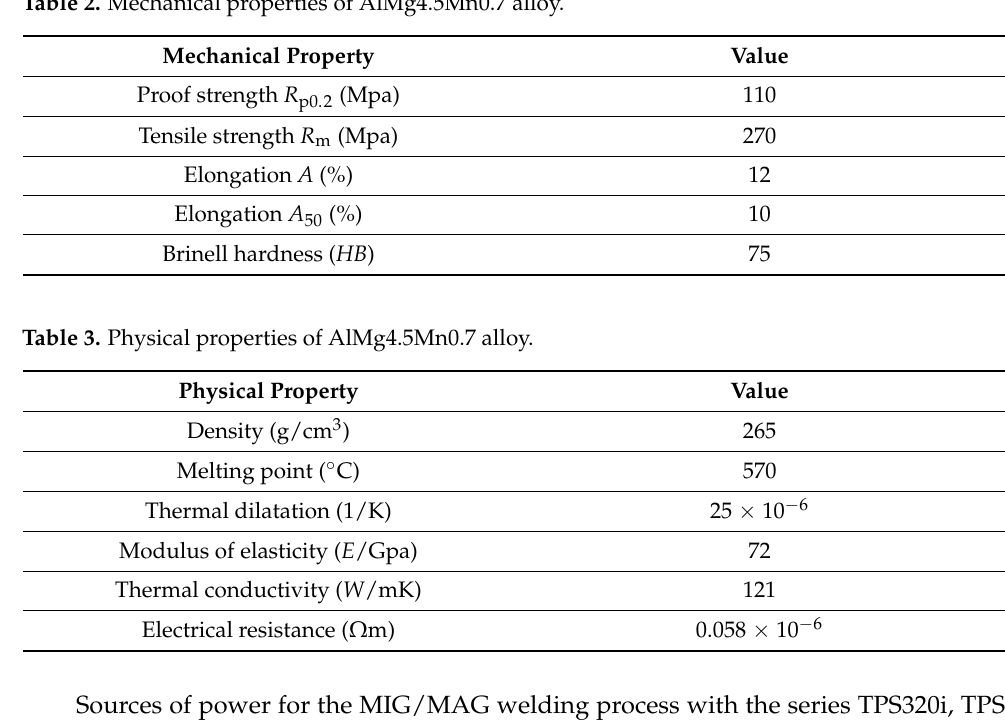
Table 2. Mechanical properties of AlMg4.5Mn0.7 alloy.